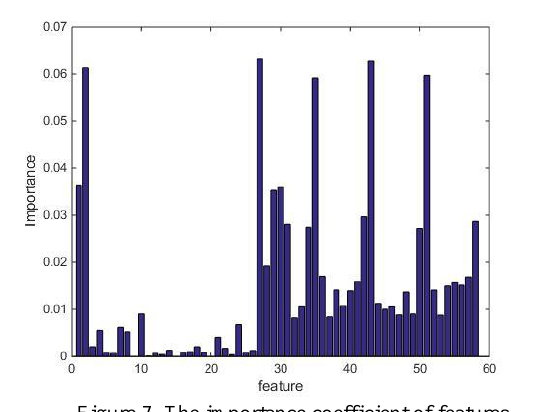
Figure 7. The importance coefficient of features